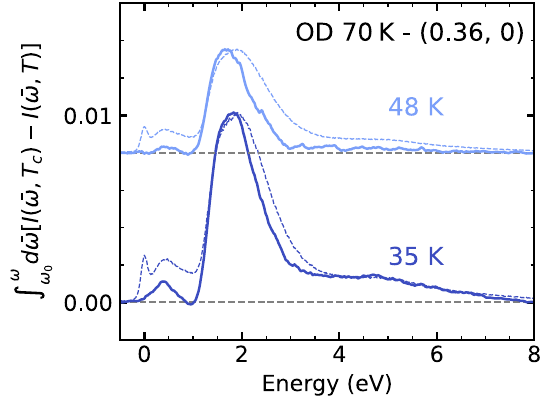
FIG. 9. Integral function G ð ω Þ defined in Eq. (A2) (solid line) and the spectrum I ð ω ; T Þ (dashed line) normalized to their maximum, for the OD 70 K sample and q ¼ ð 0 . 36 ; 0 Þ